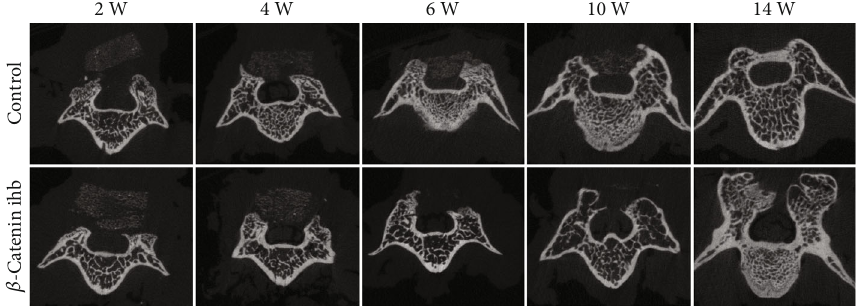
Figure 2: Micro-CT scanning of TEL in the control and β -catenin inhibition groups at the 2nd, 4th, 6th, 10th, and 14th